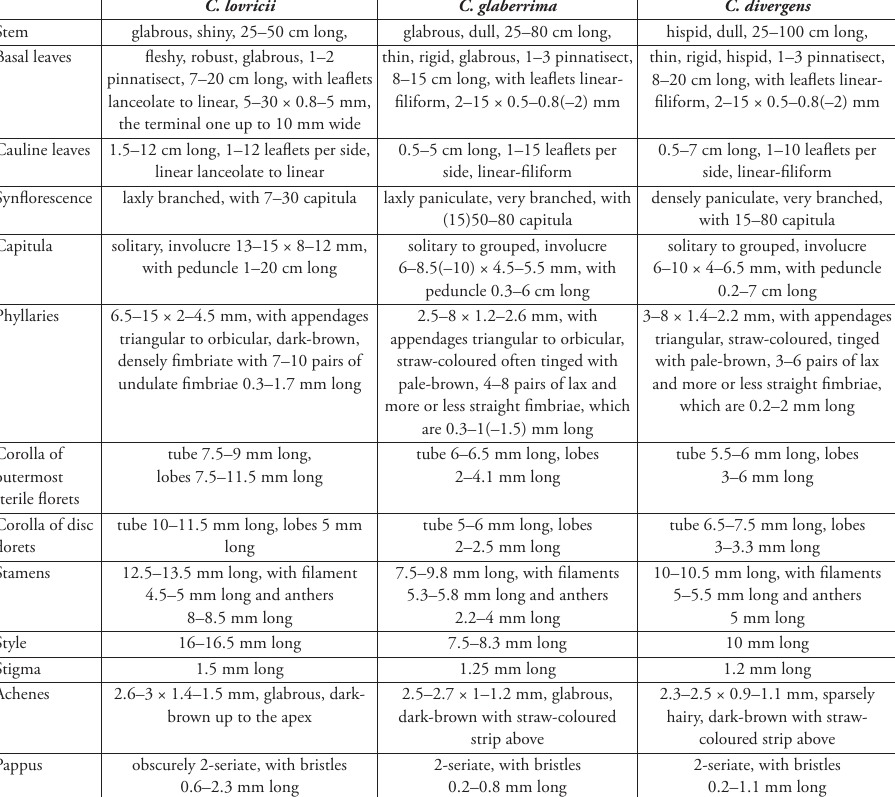
Table 1. Main diagnostic features of Centaurea lovricii , C. glaberrima and C. divergens